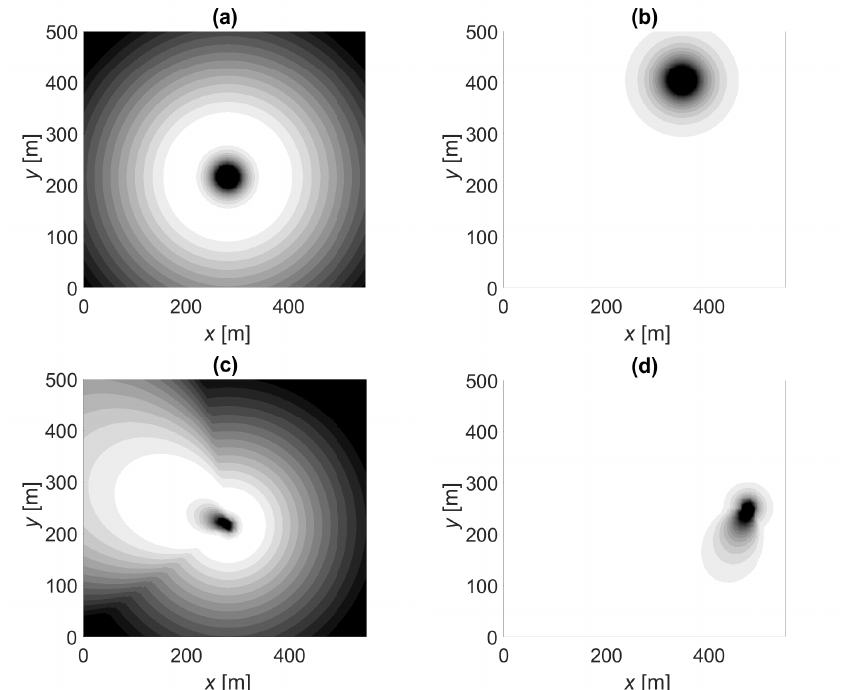
Figure 5. Likelihood function illustrations: ( a ) measured PL and omnidirectional antenna, ( b ) cen- sored PL and omnidirectional antenna, ( c ) measured PL and directive beam ( N = 8), ( d ) censored PL and directive beam ( N = 8). White is likely, gray is possible, and black is an unlikely location.